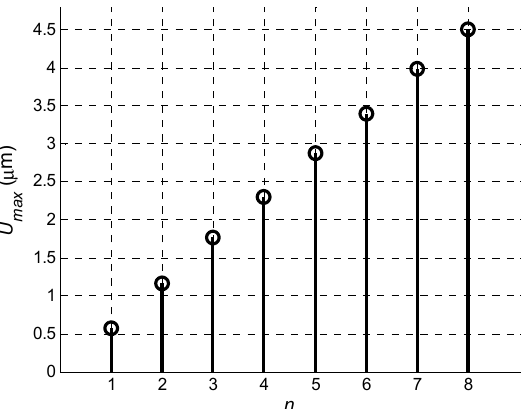
Figure 7. Amplitude of received signal U max at output of receiving array versus number of array elements n